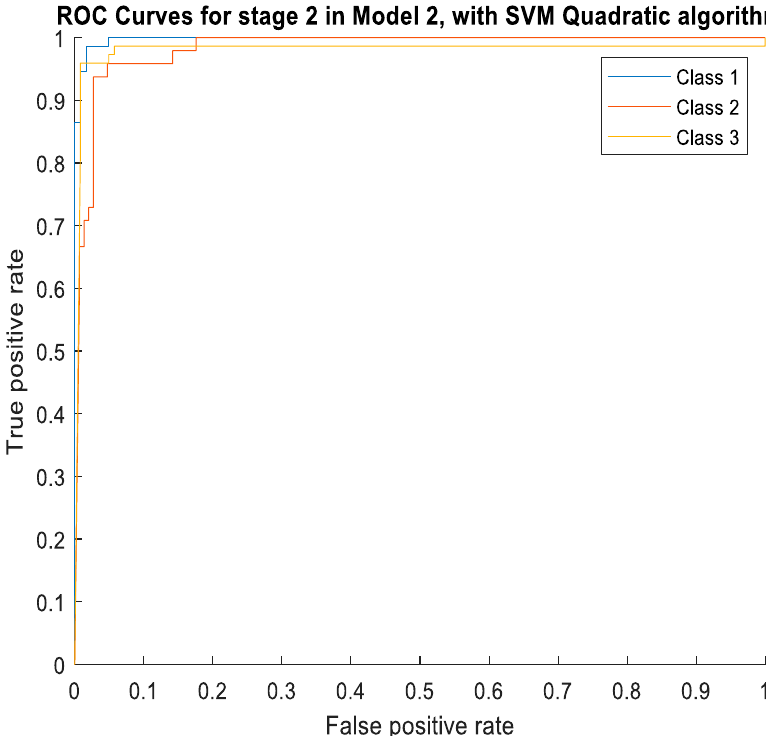
Figure 7. ROC curves for stage 2 in Model 2, with SVM Quadratic algorithm.